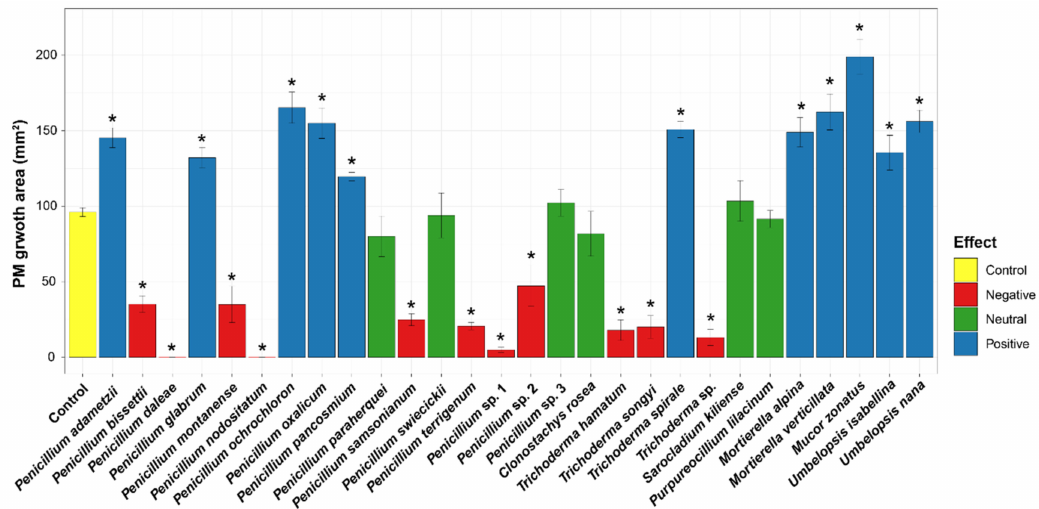
Figure 3. E ff ect of microfungal metabolite on PM growth. Average radial growth area (mm 2 ) of